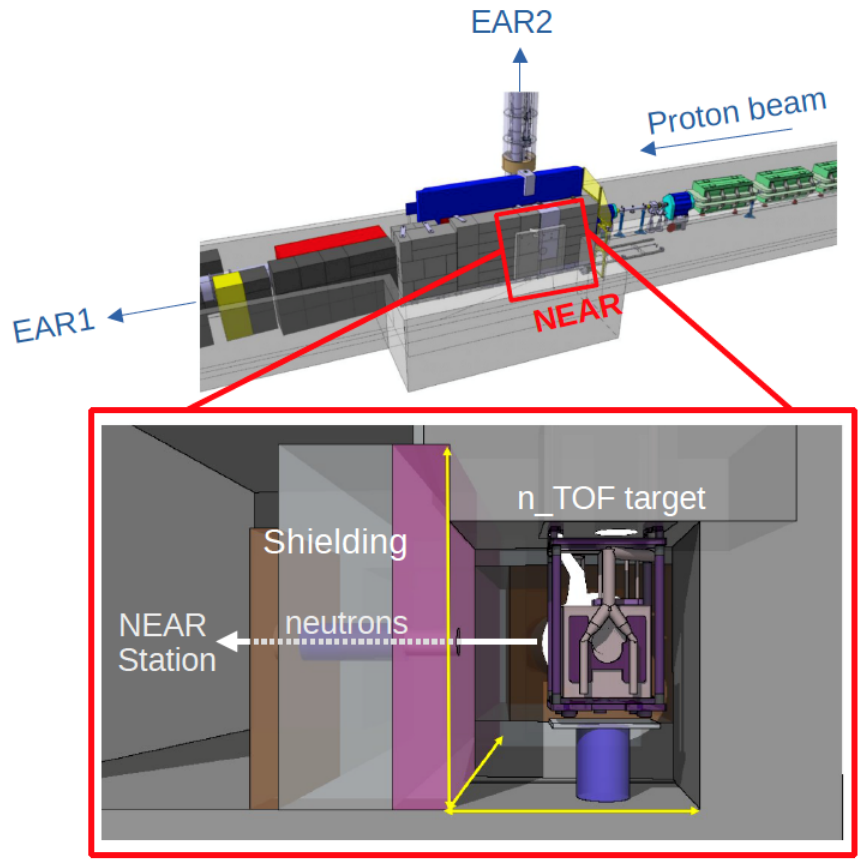
Figure 1. Layout of the n_TOF Facility. A high-intensity proton beam from the CERN’s Proton Synchrotron collides with a pure lead target, producing neutrons that travel along three flight paths toward the experimental areas: EAR1, EAR2 and NEAR. EAR1 is located 185 m from the target, EAR-2 is located 19 m above the target and NEAR at 3